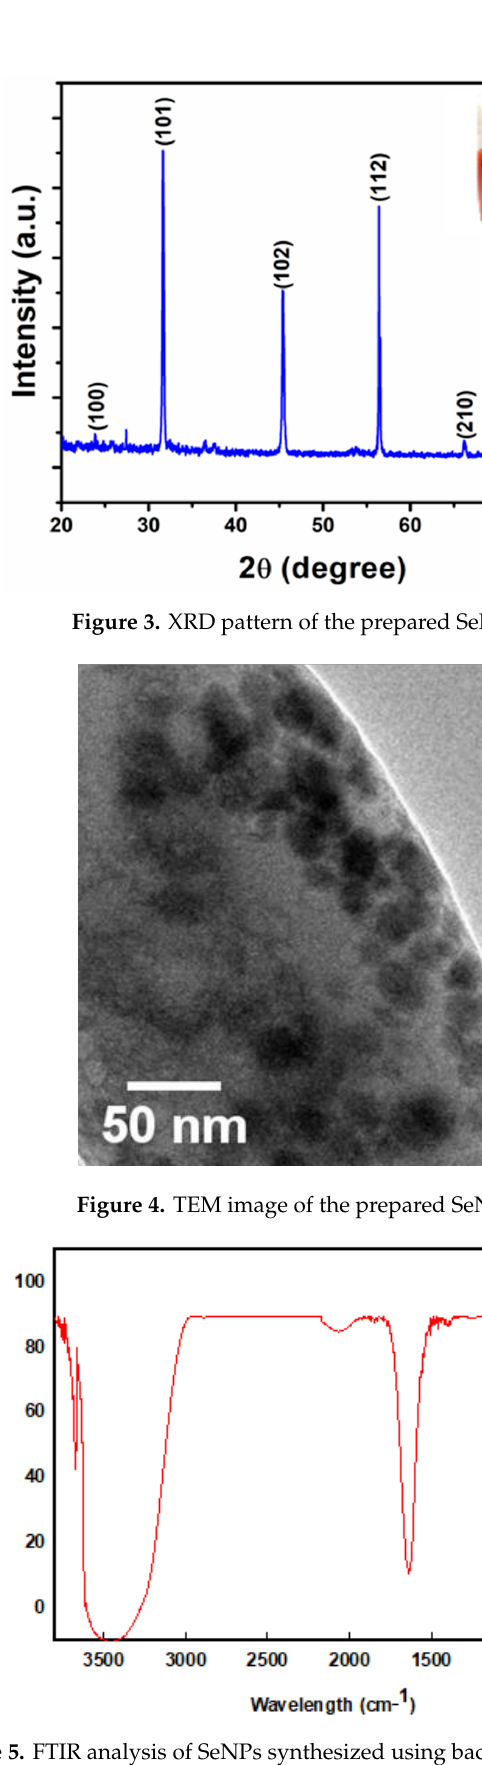
Figure 5. FTIR analysis of SeNPs synthesized using bacterial metabolites.